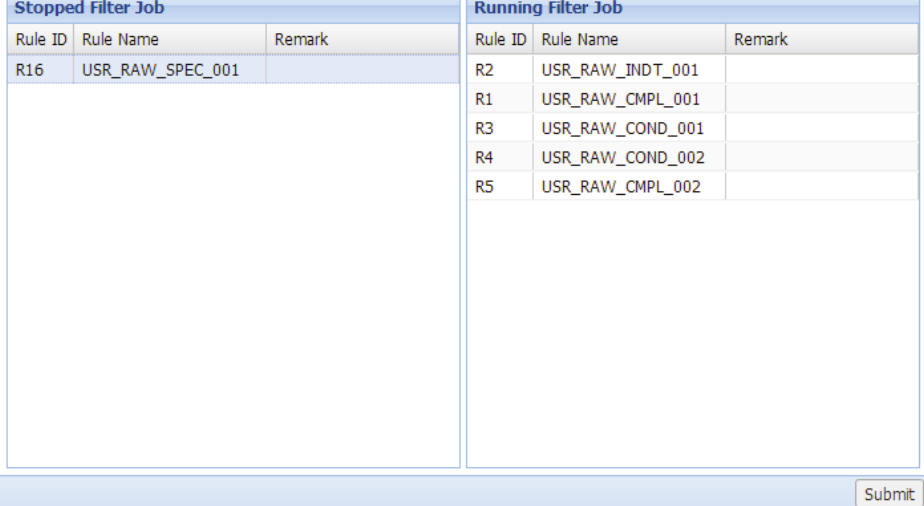
Figure 8. Example of the user interface for rules’